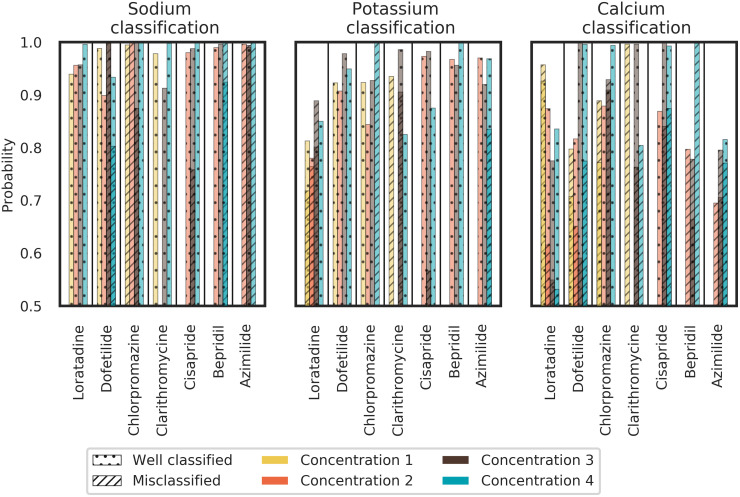
Section Channel classification, Binary classification part: Experimental data classification in binary case for each concentration.Some concentrations were not used due to the quiescence or noisy signal observation. For each concentration, the LDA classifier returns the average probability for well classified (dotted bars) and misclassified (hatched bars) compounds.